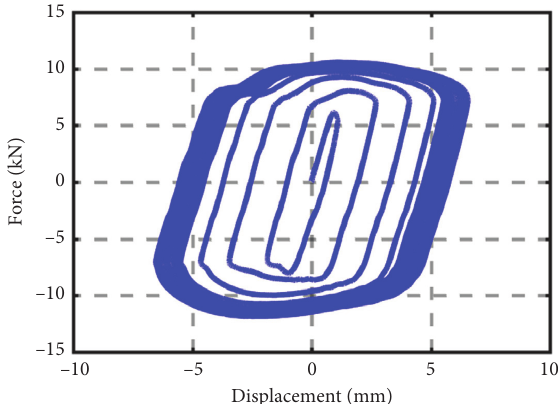
Figure 3: Relationship between damping force and